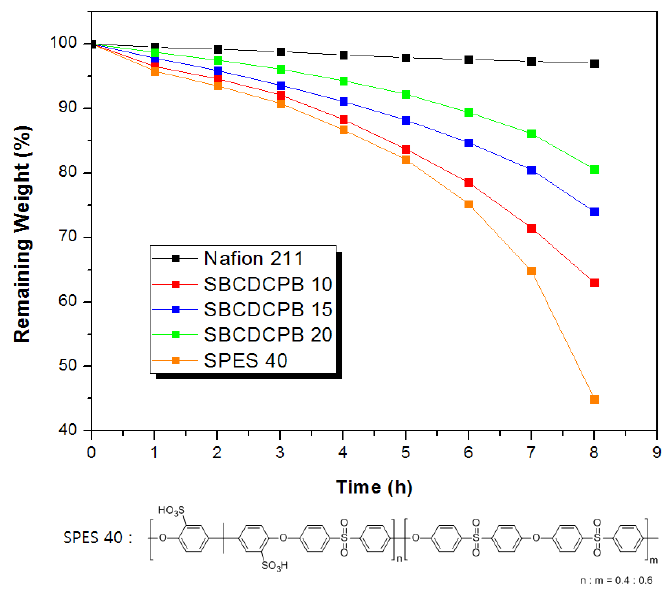
Figure 7. Fenton’ reagent (4 ppm) test of membranes. Energies 2016 , 9 , 115